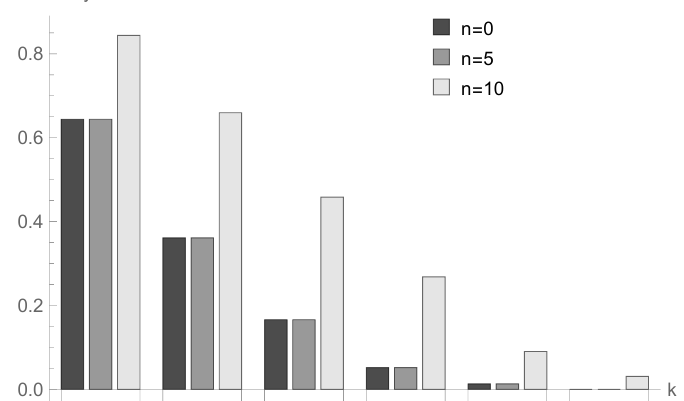
Figure 8. Conditional probabilities (cid:98) ∆ n ( k ) for deterministic processing distribution, (cid:36) = 1.00 and n = 0,5 and 10.